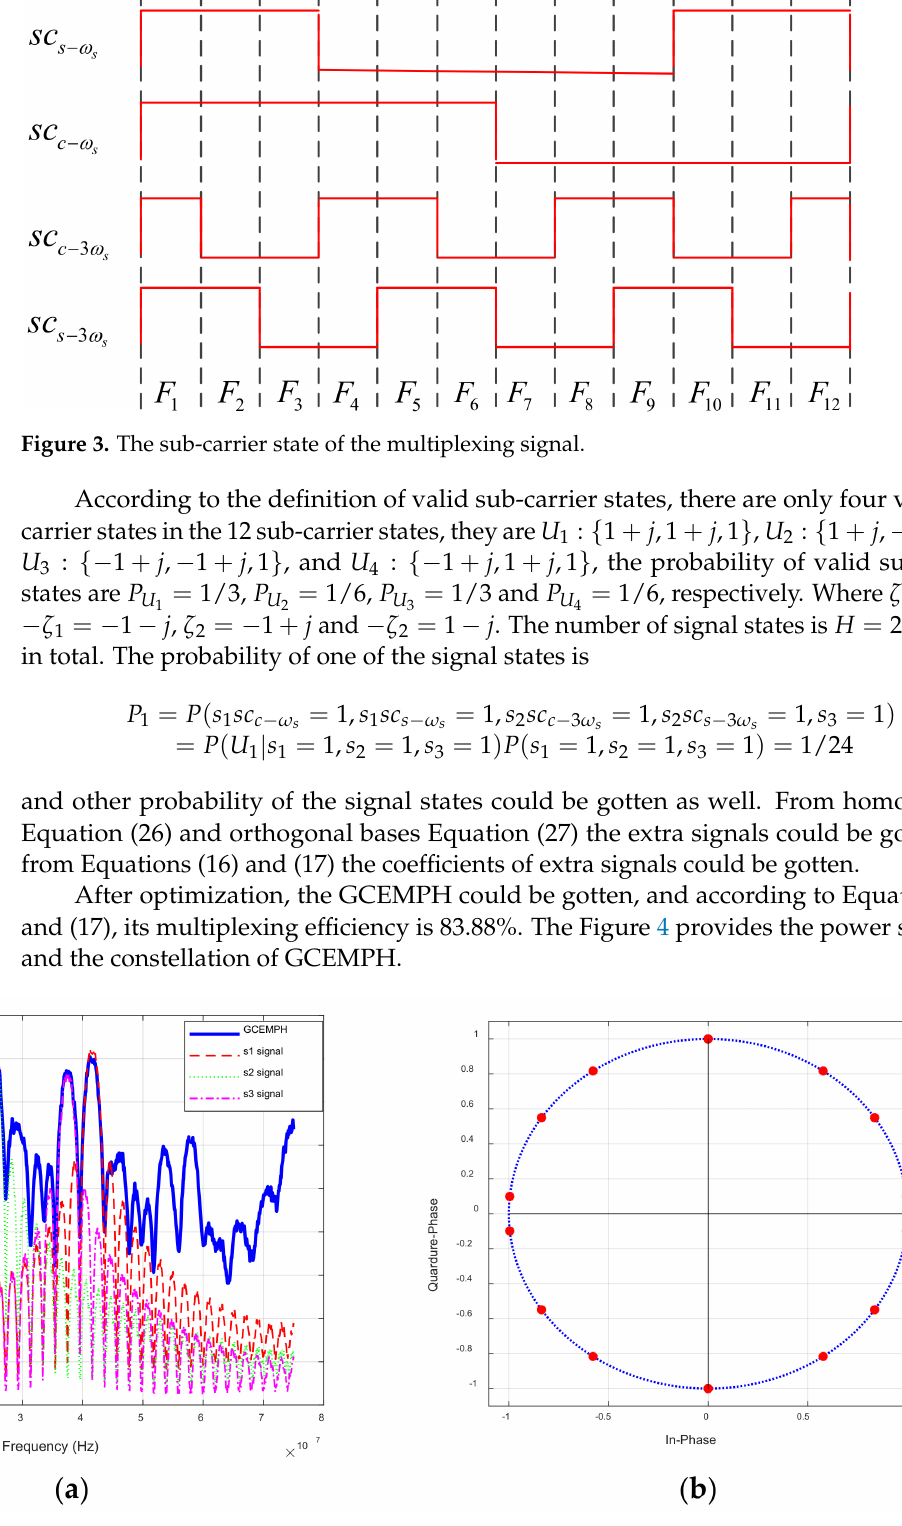
Figure 4. ( a ) The spectrum of GCEMPH and multiplexed signals; ( b ) The constellation of